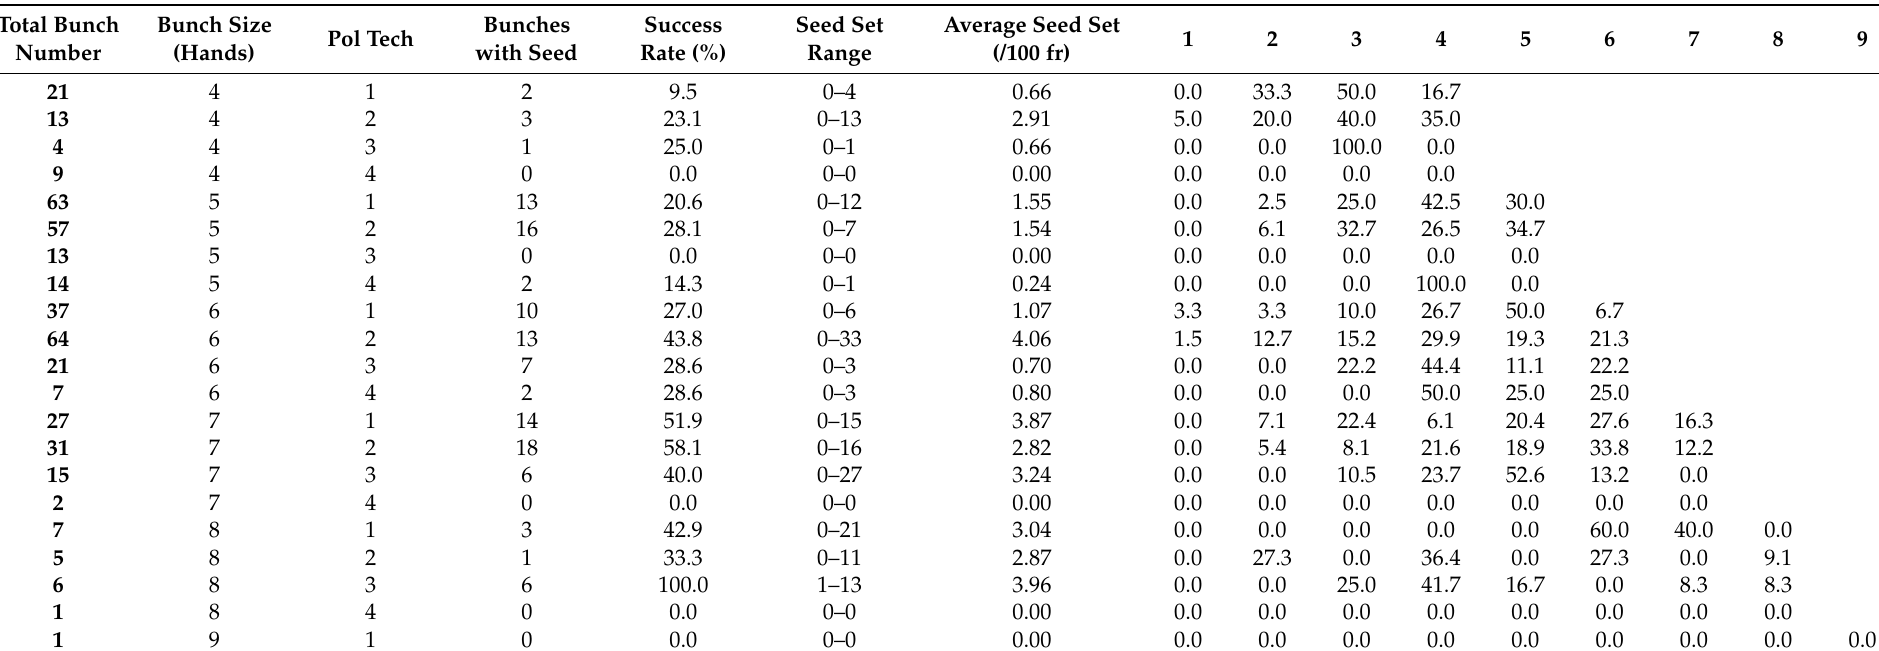
Table A1. Percentage seed set per hand and by number of hands per bunch in “Enzirabahima”, pollinated with “Calcutta 4”, using different pollination techniques, between January 2016 and January